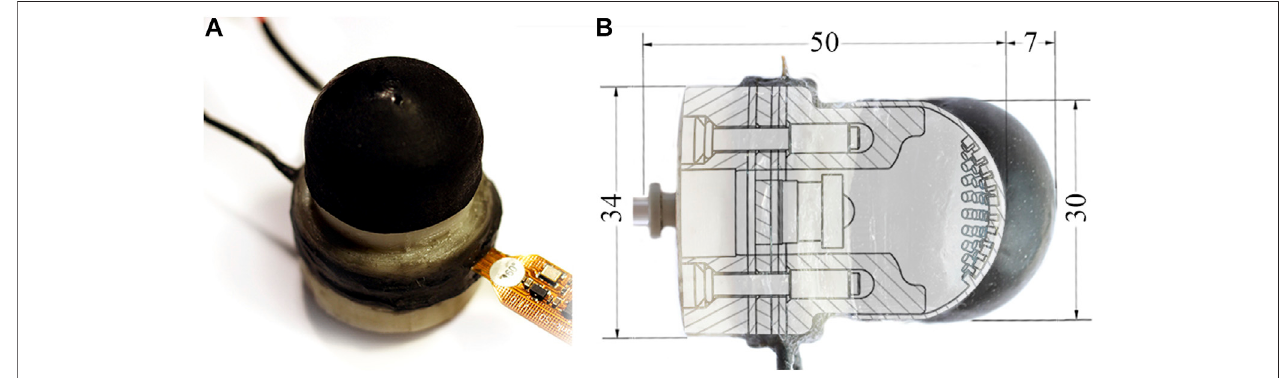
FIGURE 1 | (A) The soft actuating tactile sensor. (B) A sectioned view demonstrating the sensor ’ s internal structure as well as its potential for active palpation. Pressurizing the sensor achieves linear actuation (max of 7 mm) through expanding the soft tactile membrane, and thus additionally modi fi es its effective